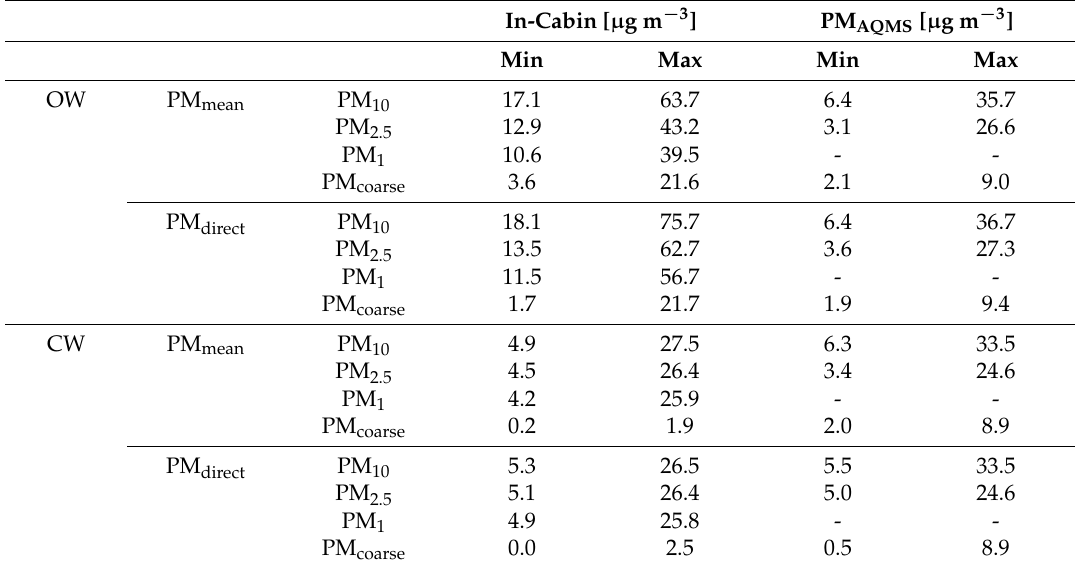
Table 3. Minimum and maximum concentrations for different PM fractions and AQMS data.